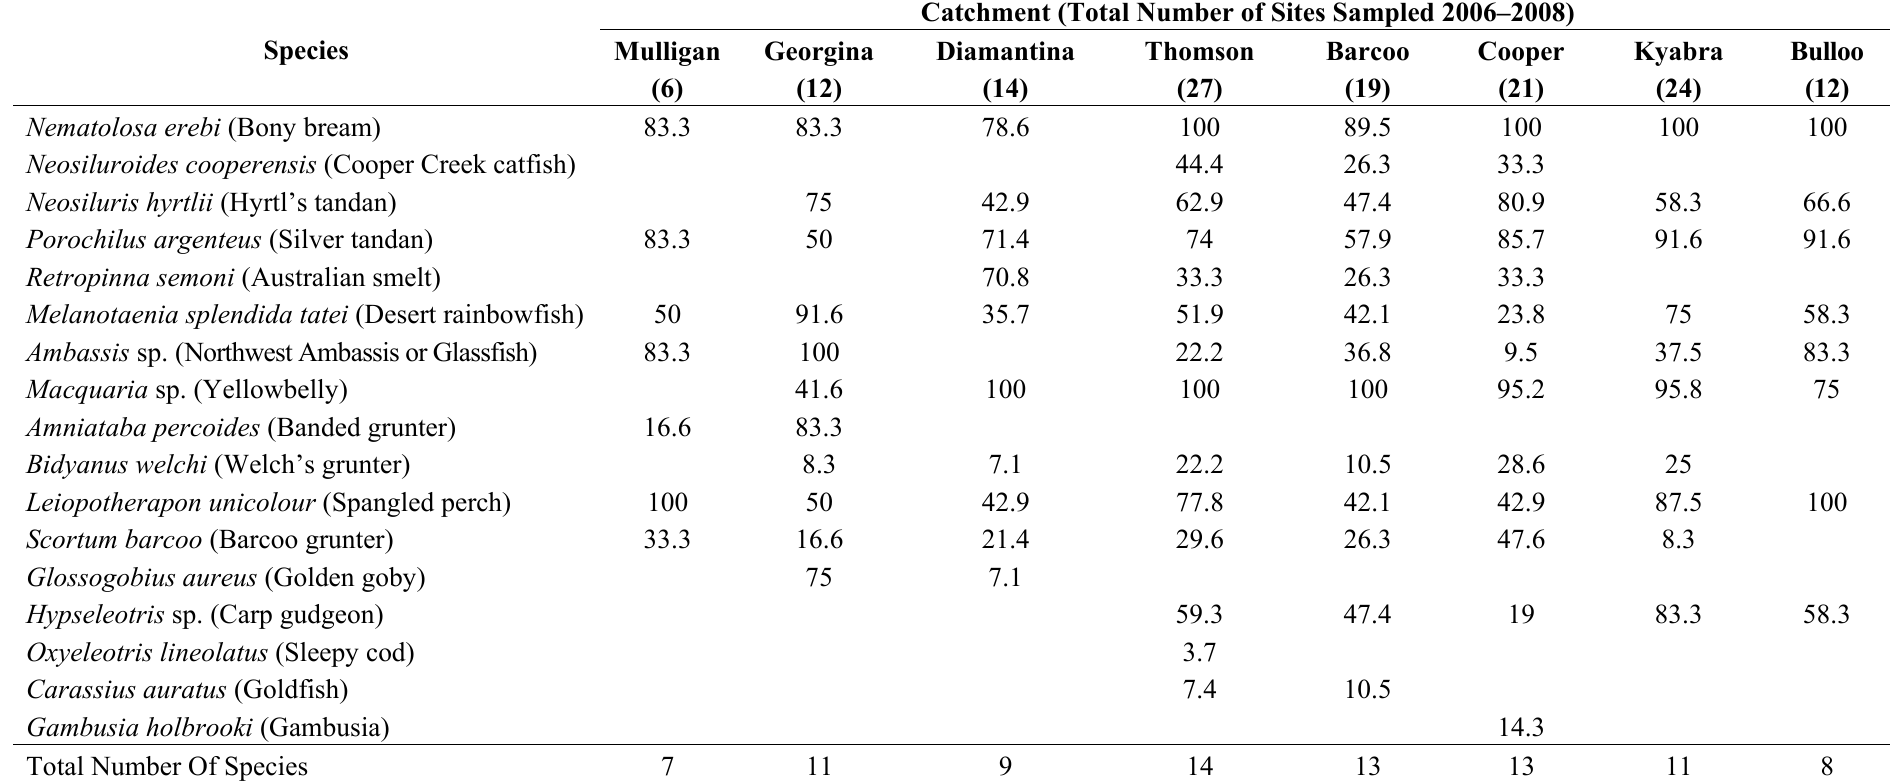
Table 1. Fish species presence in sampled catchments of the Queensland Lake Eyre Basin between 2006 and 2008. Percentages represent the frequency of species presence in relation to the total number of sites sampled in each catchment, (eg: 100% = present at every site, smaller percentages = present at fewer sites). Blank areas indicate the species was absent from the